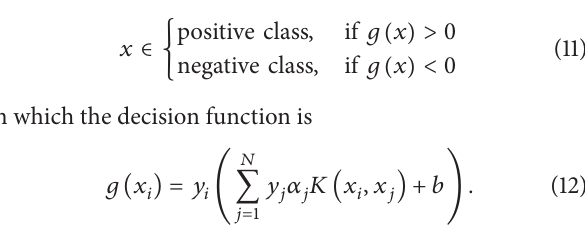
Figure 13: Gear wear.